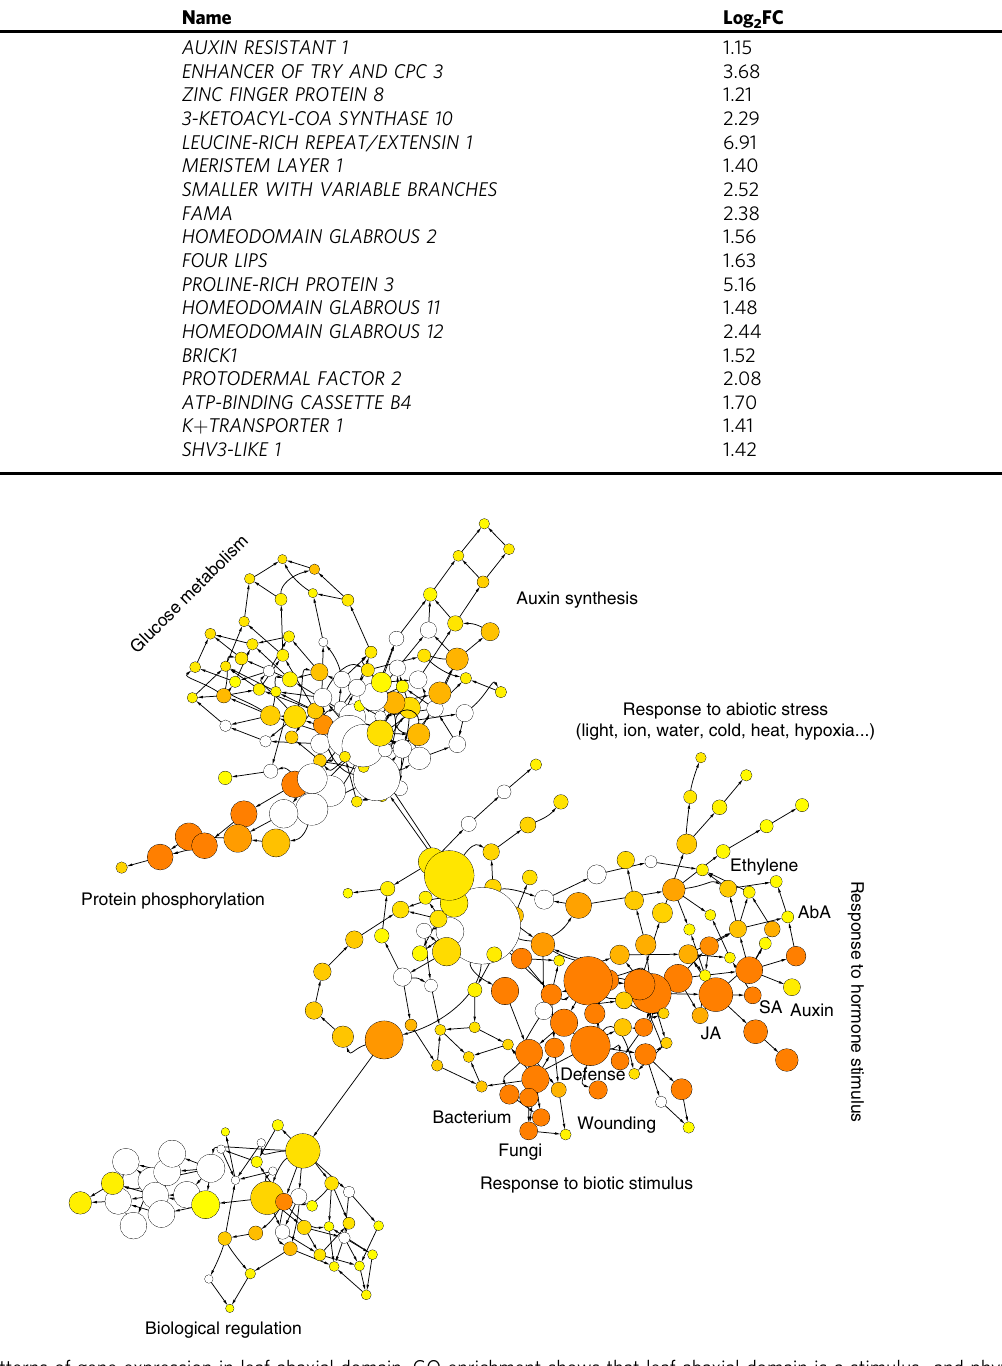
Fig. 7 Dominant patterns of gene expression in leaf abaxial domain. GO enrichment shows that leaf abaxial domain is a stimulus- and phytohormones- responsive center. The regulatory relationship was displayed by